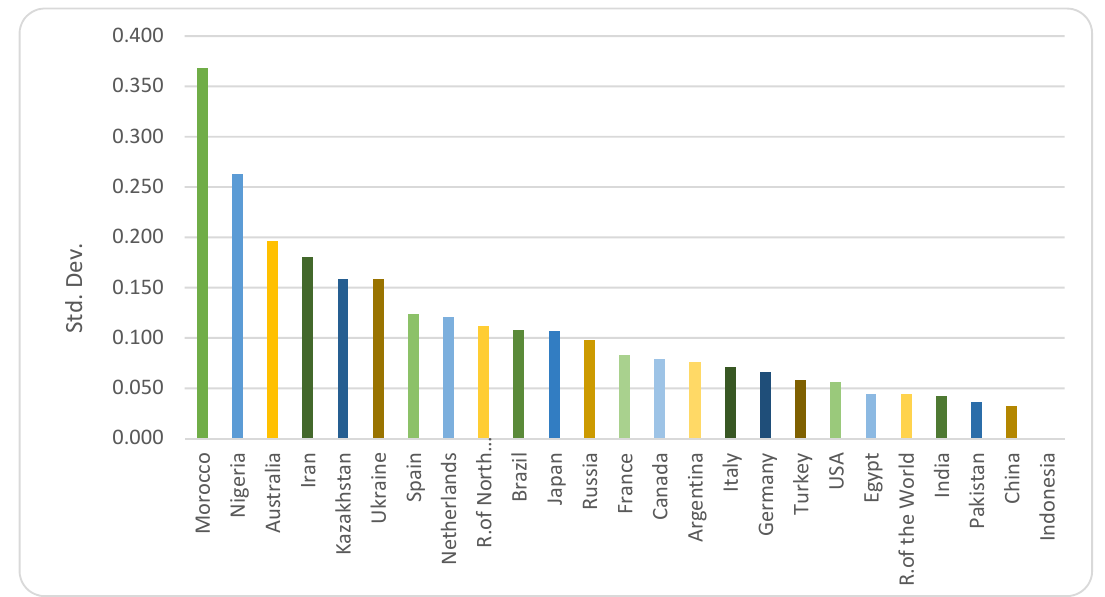
Figure 1. Standard deviations of productivity (ARIMA residuals) in 25 countries/regions, 1992–2016.